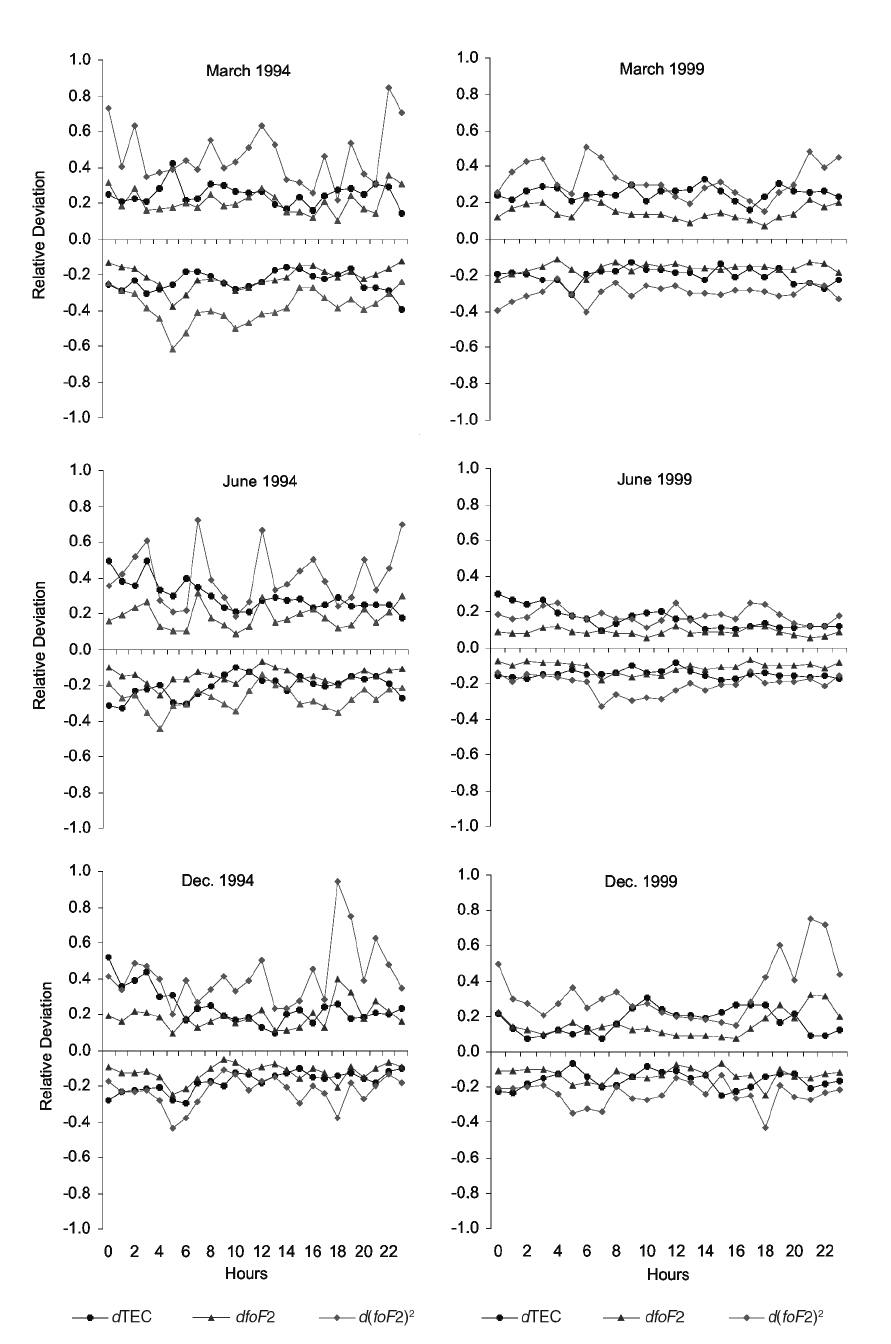
Fig. 9.2b. Upper and lower deciles in TEC, foF 2 and ( foF 2) 2 . GPS data have been